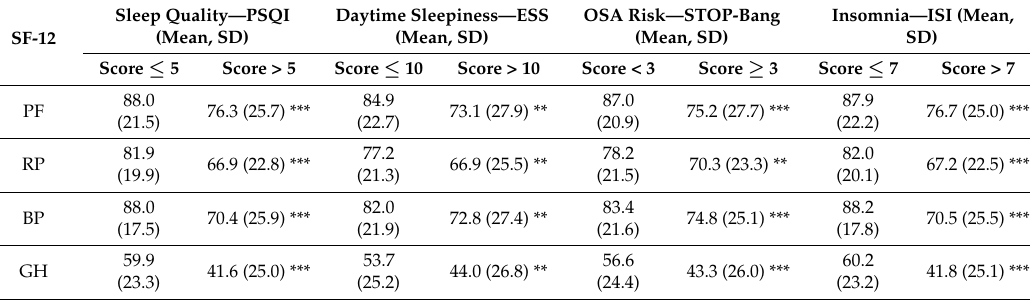
Table 2. Differences in the SF-12 variables according to sleep status